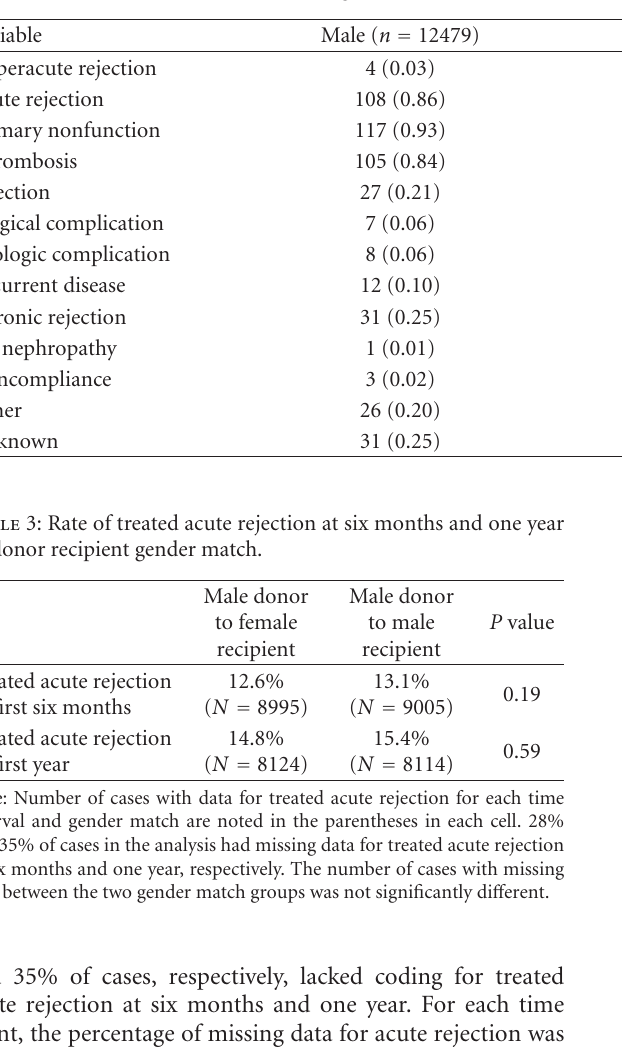
Table 2: Causes of graft loss not due death with function in the first 180 days after transplant.